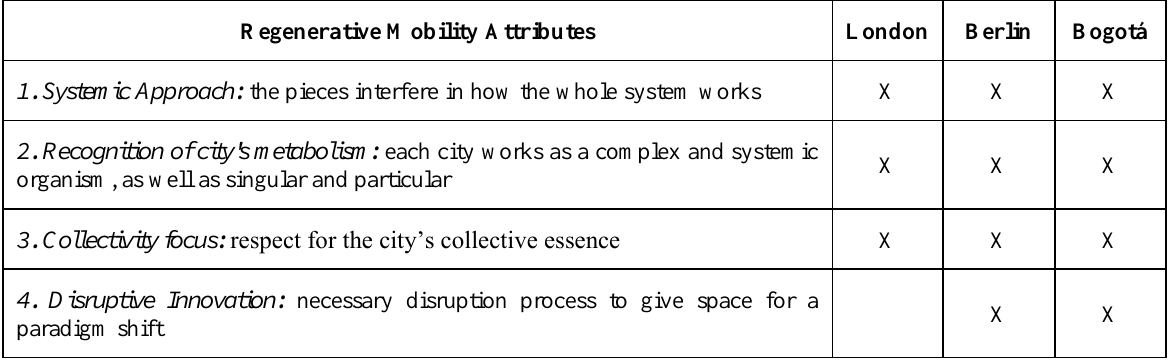
Table 3.Synthesis of Regenerative Mobility Attributes. Source: